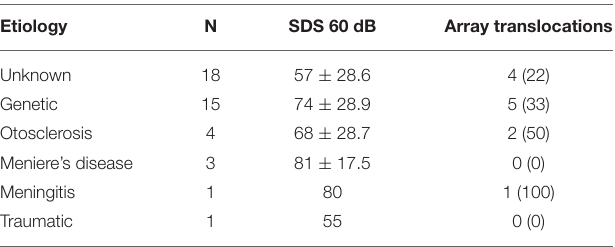
TABLE 3 | Speech perception and array translocation according to the etiology of the hearing loss.